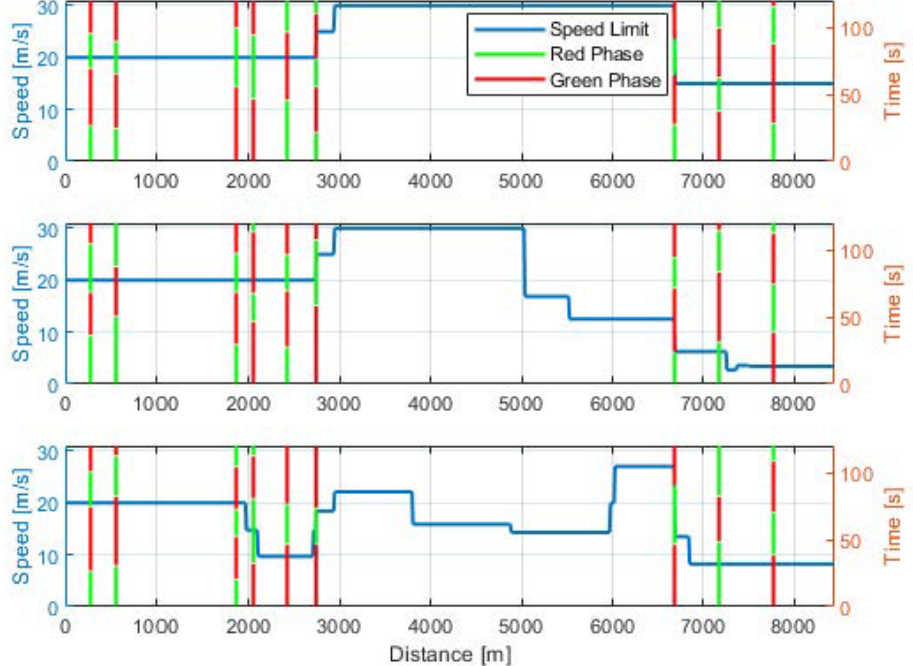
Figure 7. Selected route with random traffic and